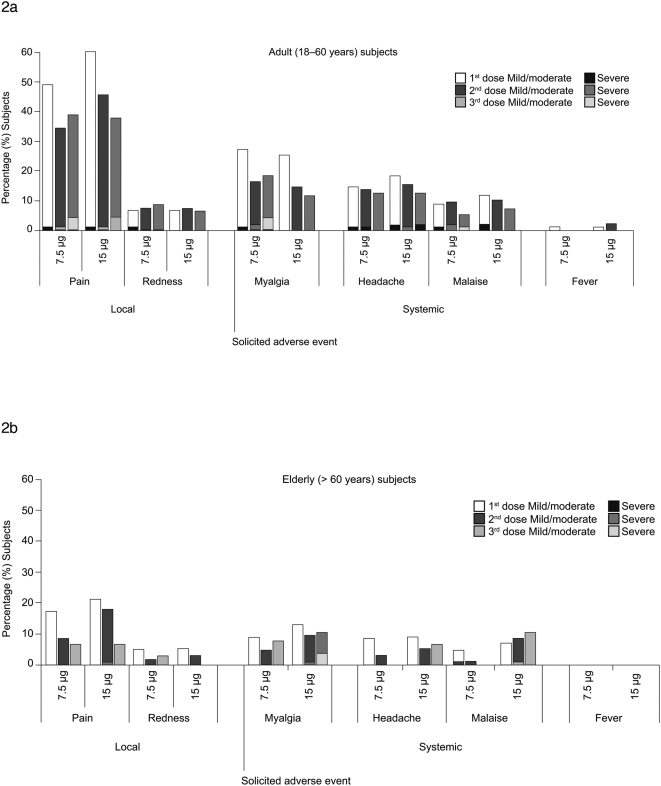
Most commonly reported solicited systemic adverse reactions.Classified as mild/moderate (white bars) or severe (grey bars) after the first, second and third vaccination in non-elderly adults (18–60 years; part a) and in elderly adults (>60 years; part b).